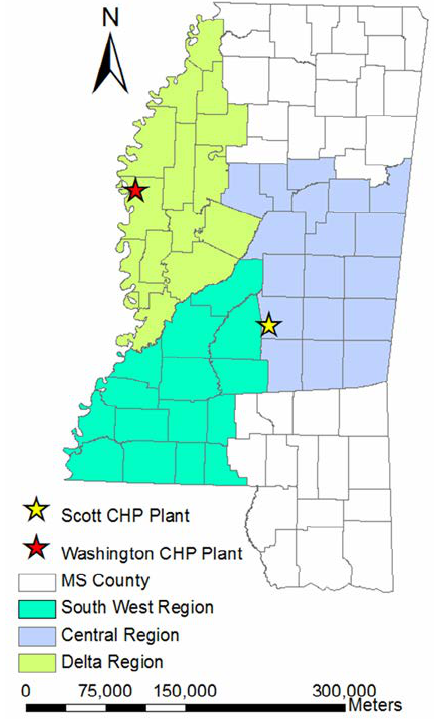
Figure 1. Map showing the location of the CHP plants considered in this